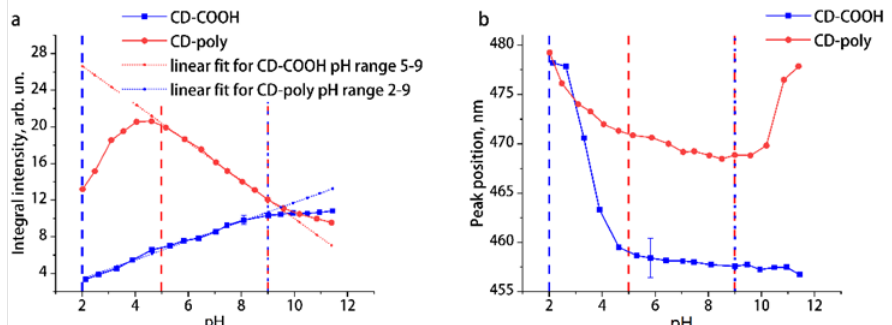
Figure 8. Dependence of the integral intensity ( a ) and the position of the maximum ( b ) of the UCL spectra of aqueous solutions of CD-COOH and CD-poly on pH. The vertical lines represent the pH limits of applying the linear fit to UCL intensity vs. pH.